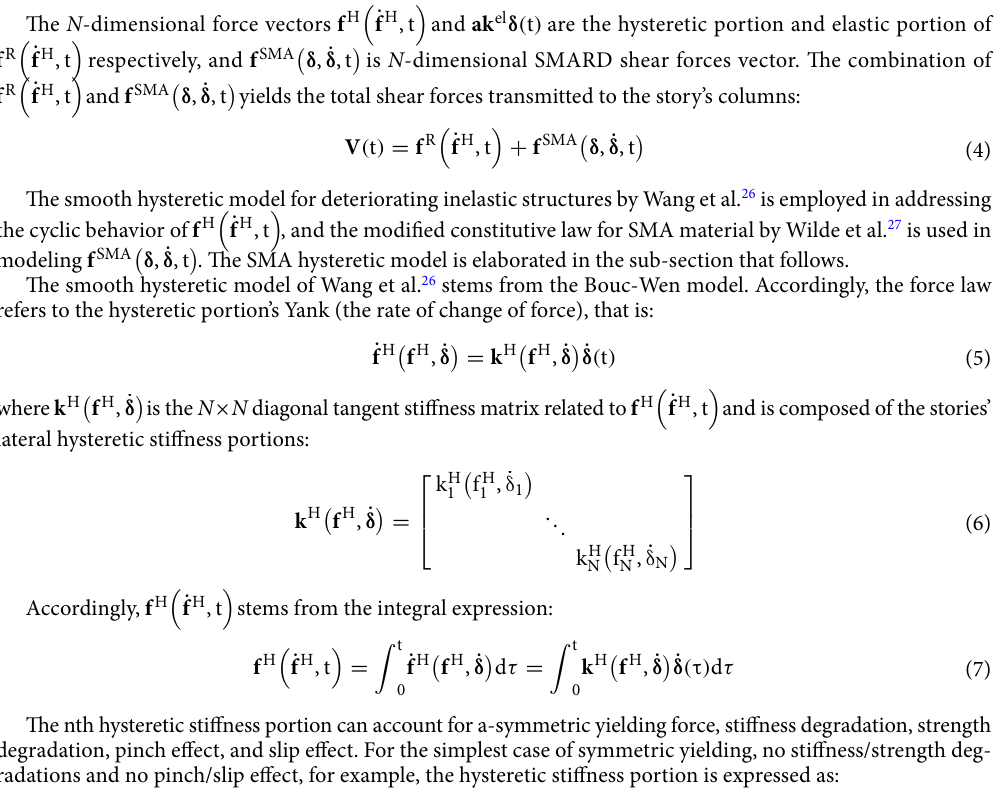
The N -dimensional force vectors f H